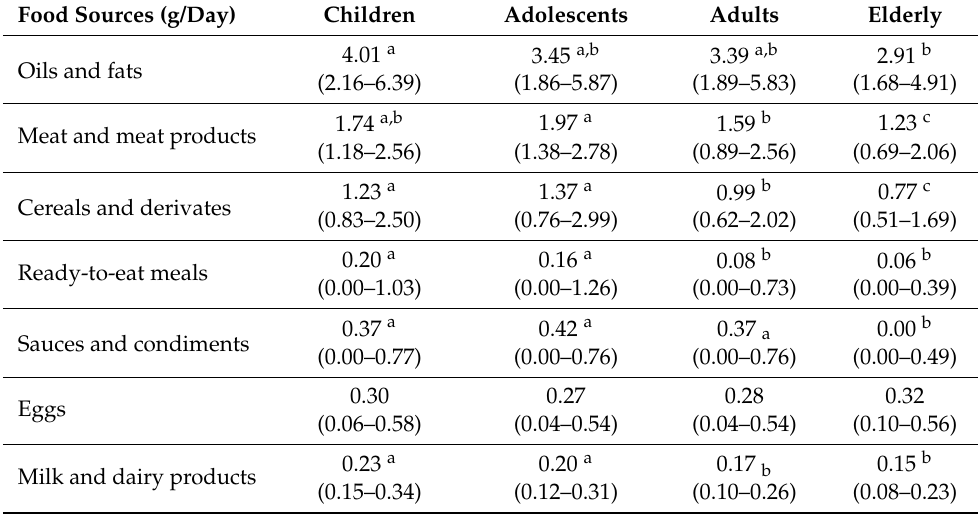
Table 19. Contribution of dietary food sources to linoleic acid (LA) intakes per age group among the ANIBES Study population.